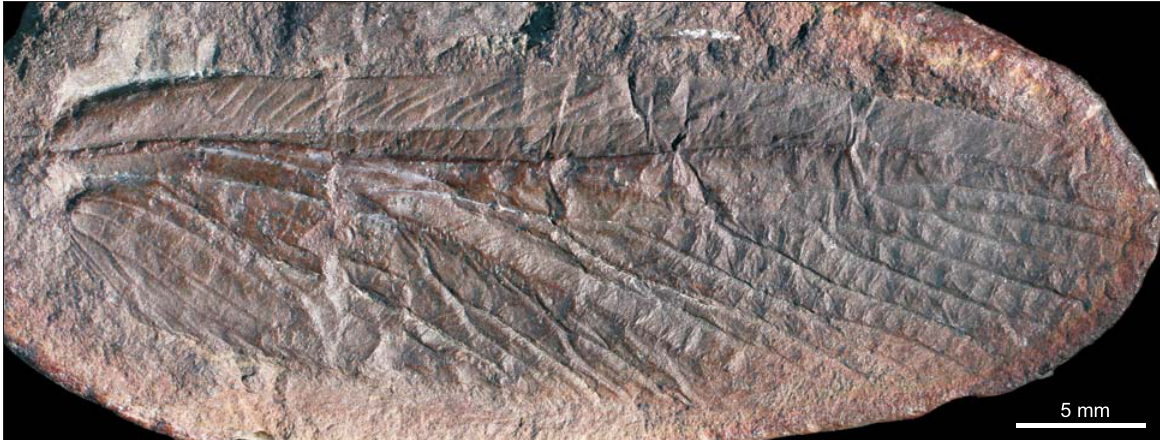
Fig. 3. Forewing venation of archaeorthopteran insect Nacekomia rossae Richardson, 1956, holotype (FM PE791), Pensylvannian, Moscovian (Westphalian D), Mazon Creek Lagerstätte, Ilinois,